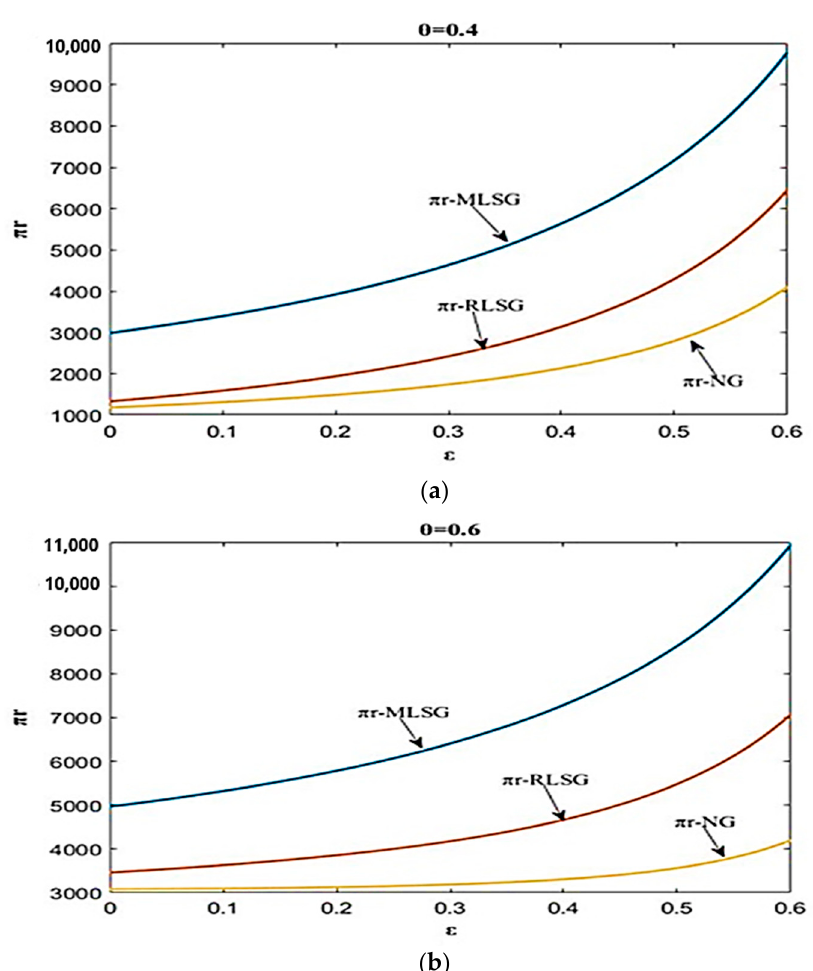
Figure 7. A decentralised decision model for retailer pricing decision options: ( a ) low consumption channel preference 𝜃 and ( b ) high consumption channel preference 𝜃 .